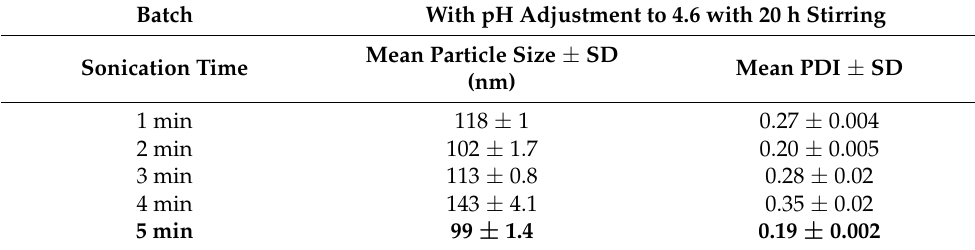
Table 4. Optimization of sonication time of chitosan solution for BC-NPs. Batch With pH Adjustment to 4.6 with 20 h Stirring Sonication